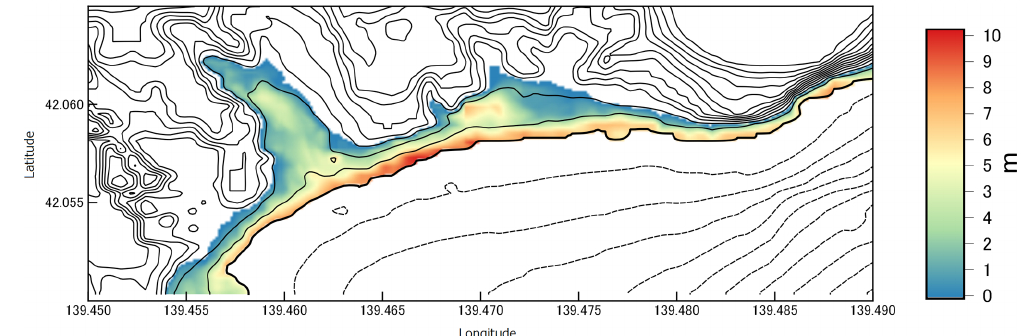
Figure 24. Inundation map of Hamatsumae region with 4m contours of bathymetry and topography.